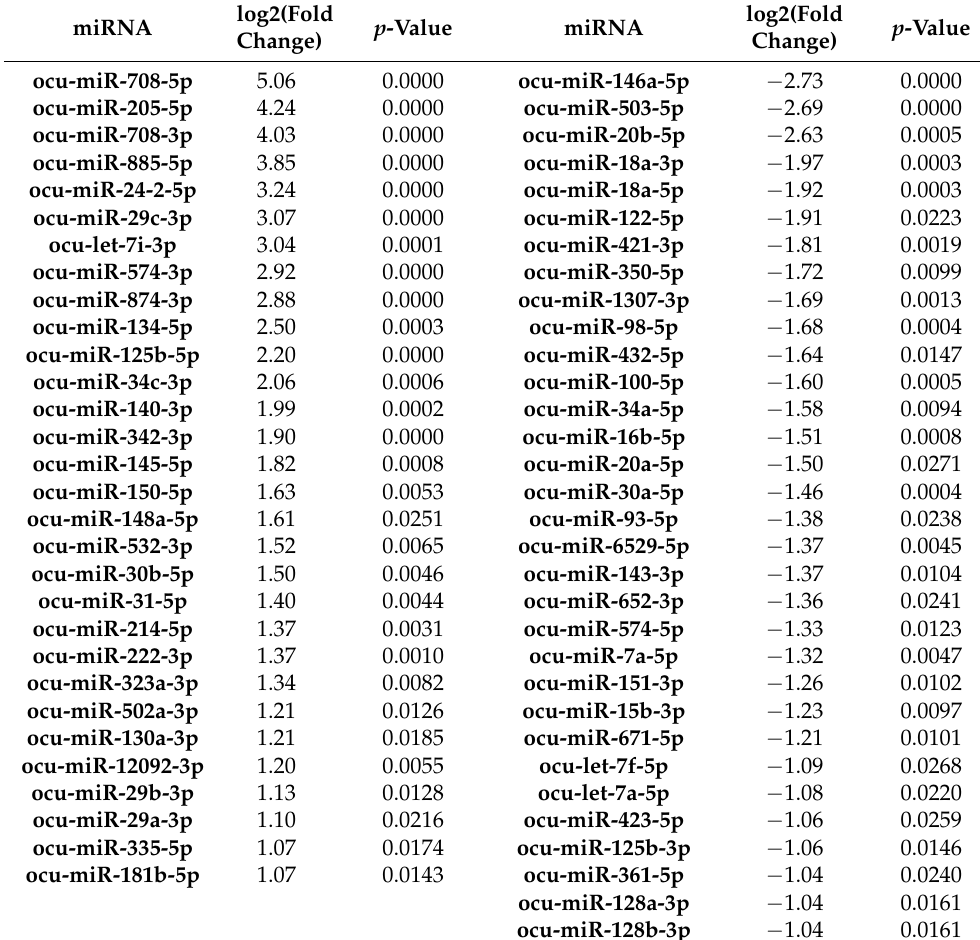
Table 1. List of significantly up/down-expressed mature microRNAs (miRNAs): Exo-A versus Exo-G.